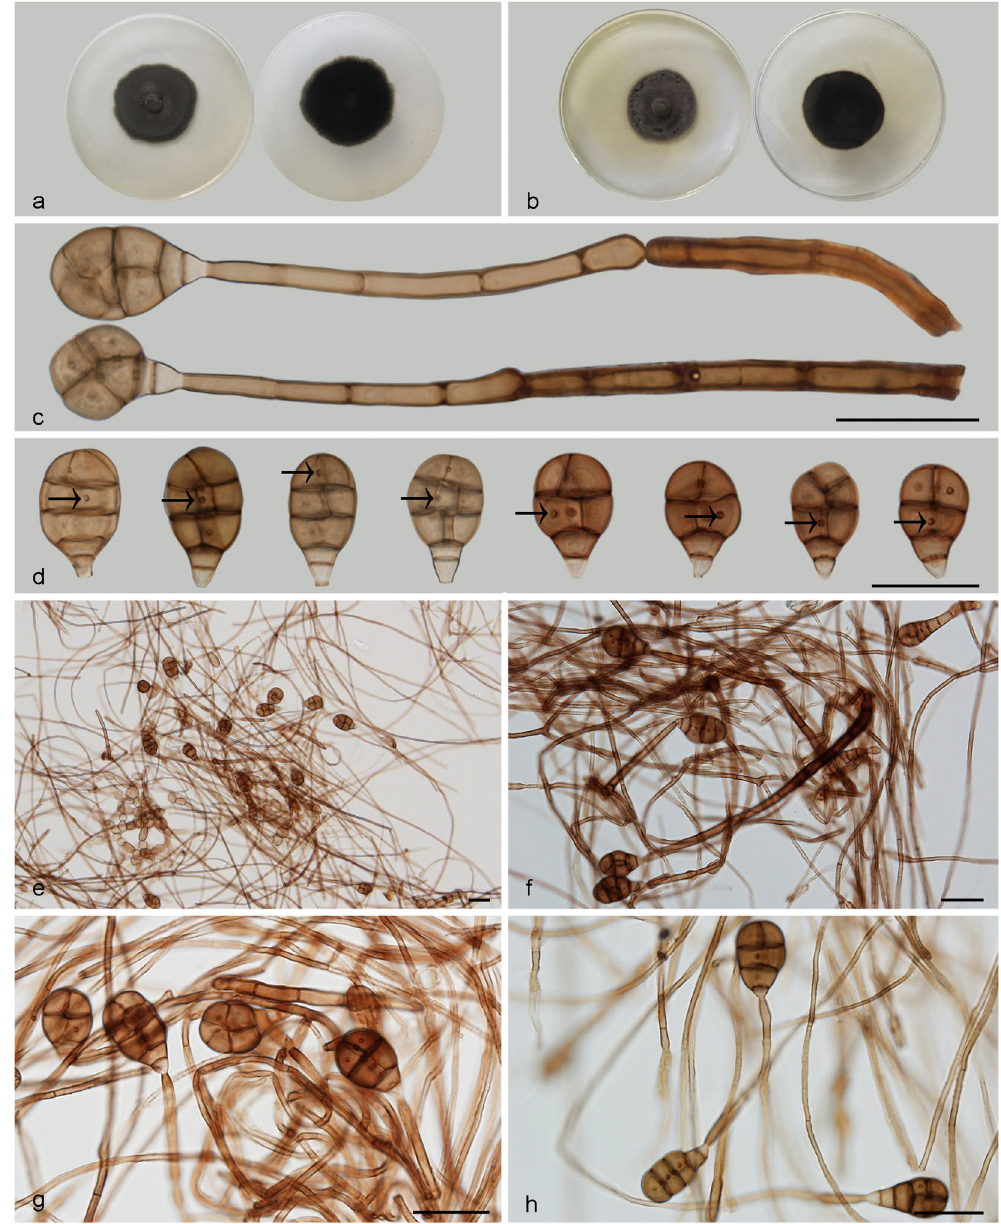
Figure 6. Acrodictys liputii. ( a ) Colony on PDA (surface and reverse). ( b ) Colony on MEA (surface and reverse). ( c , d ) From natural substrate (HSAUP H1883): ( c ) Conidiophores with conidia, ( d ) Conidia. ( e – h ) From PDA (CGMCC 3.18646): Conidiophores and conidia. — Scale bars = 20 μ